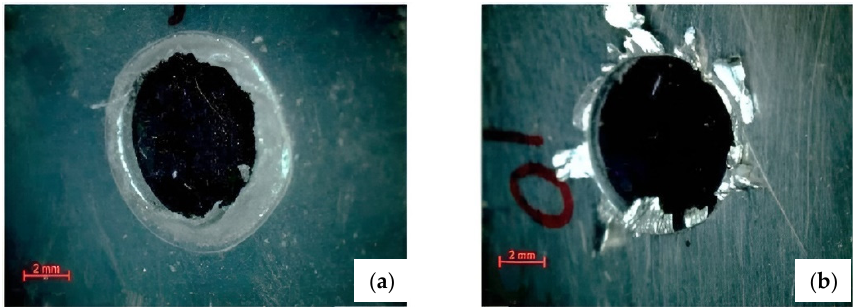
Figure 4. Burr types: ( a ) uniform and ( b ) crown [112].